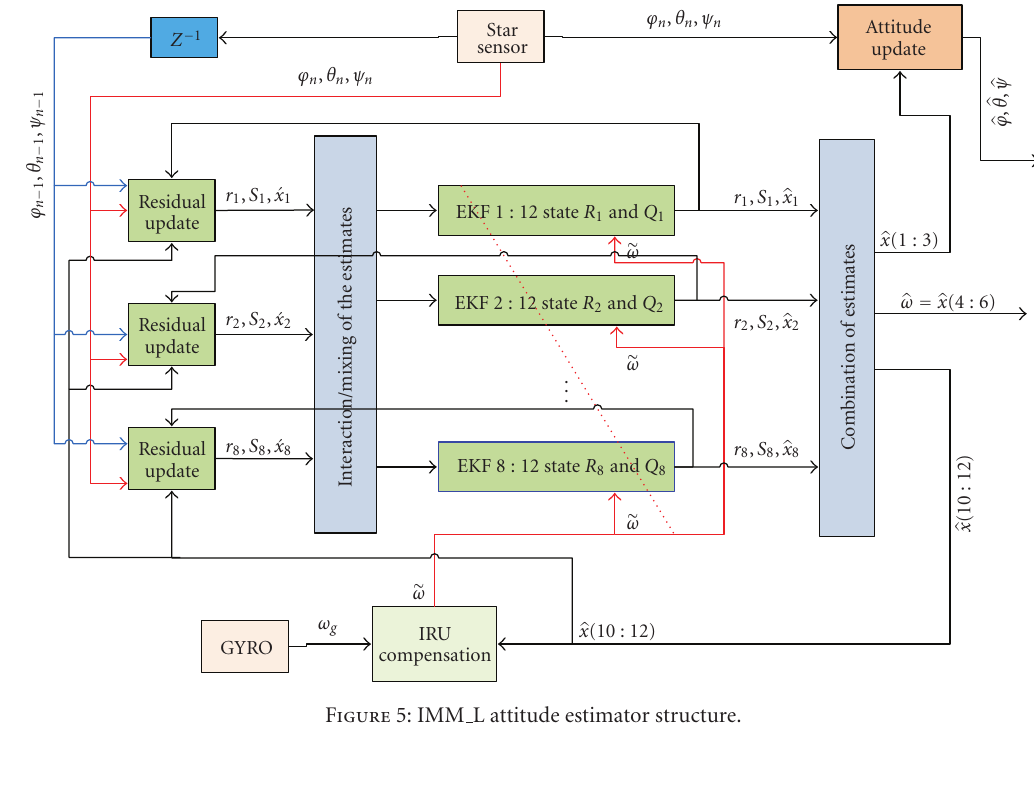
Figure 5: IMM L attitude estimator